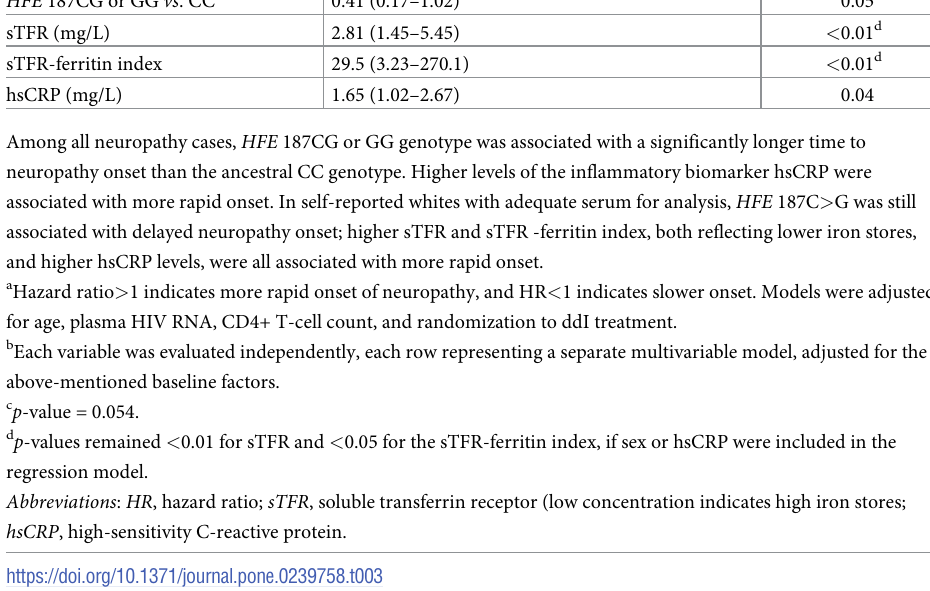
Self-reported white cases with HFE genotype and serum iron data (N = 28)